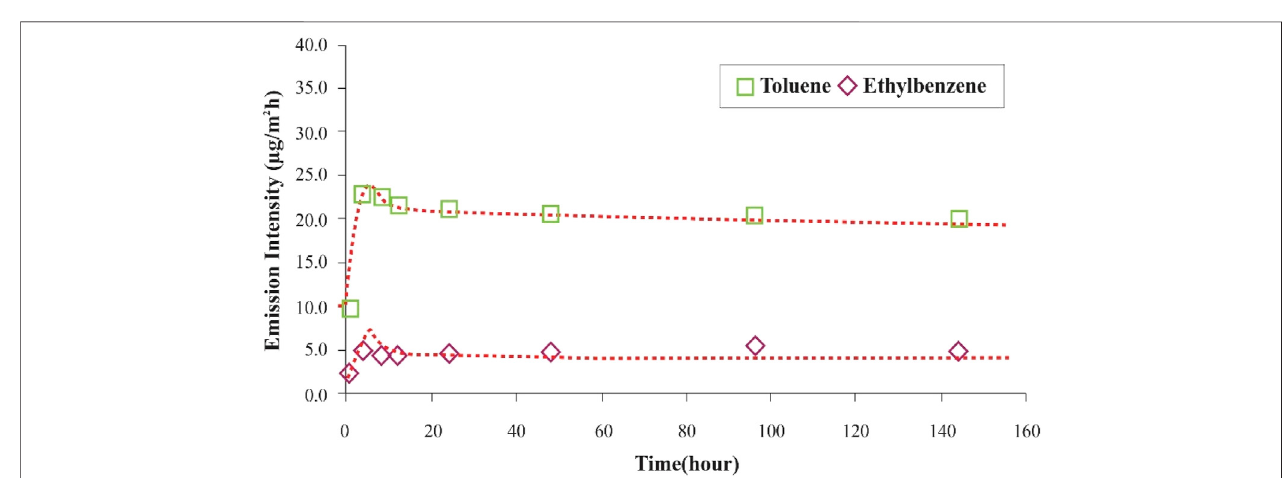
FIGURE 8 | Emission pattern of toluene and ethylbenzene from fl ooring.